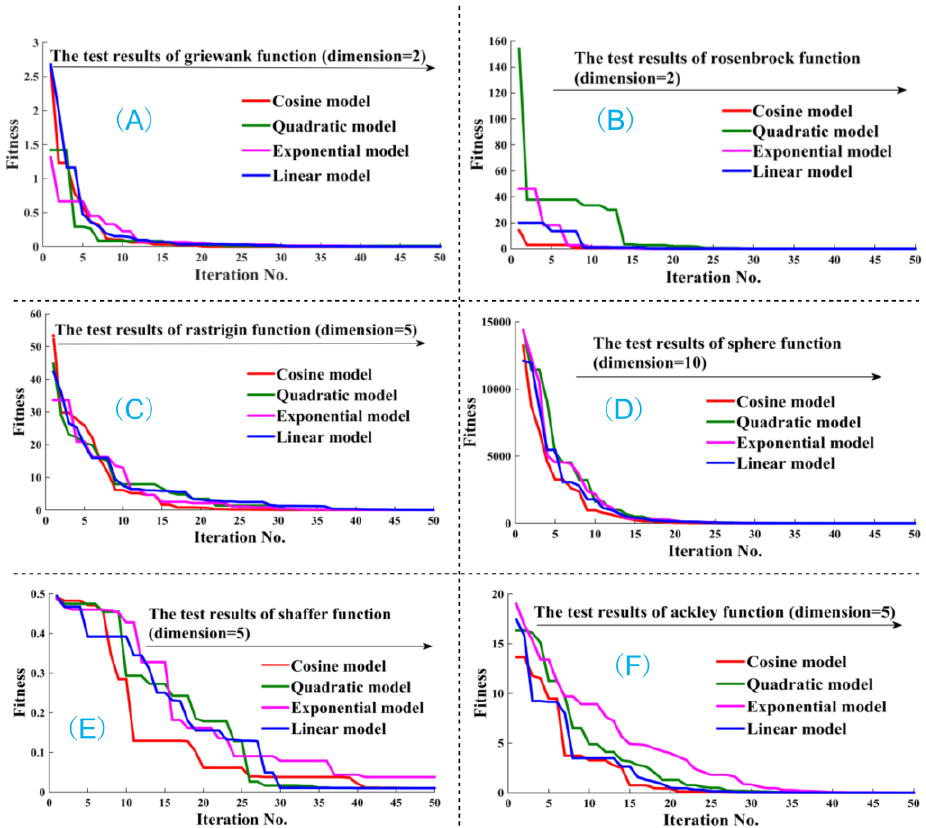
Figure 5. The comparison of convergence speed for four migration strategies in BBODE. In Figure 5, ( A ) four kinds of migration strategies (i.e., cosine model, quadratic model, exponential model, linear model) were tested by griewank function with the dimension 5. From the fitness curve in ( A ), quadratic model has the better convergence speed and accuracy. In ( B ), four kinds of migration strategies were tested by rosenbrock function with the dimension 2. From ( B ), considering convergence speed and accuracy, we can conclude that cosine model has a superior performance. Similarly, in ( C – F ), four kinds of migration strategies were tested by rastrigin function with the dimension 5, sphere function with the dimension 10, shaffer function with the dimension 5 and ackley function with the dimension 5, respectively. From ( C – F ), compared with quadratic, exponential, linear models, the convergence speed and accuracy of cosine model remarkably illustrate its excellent performance. Summarizing, cosine model is a superior migration strategy in BBODE algorithm.